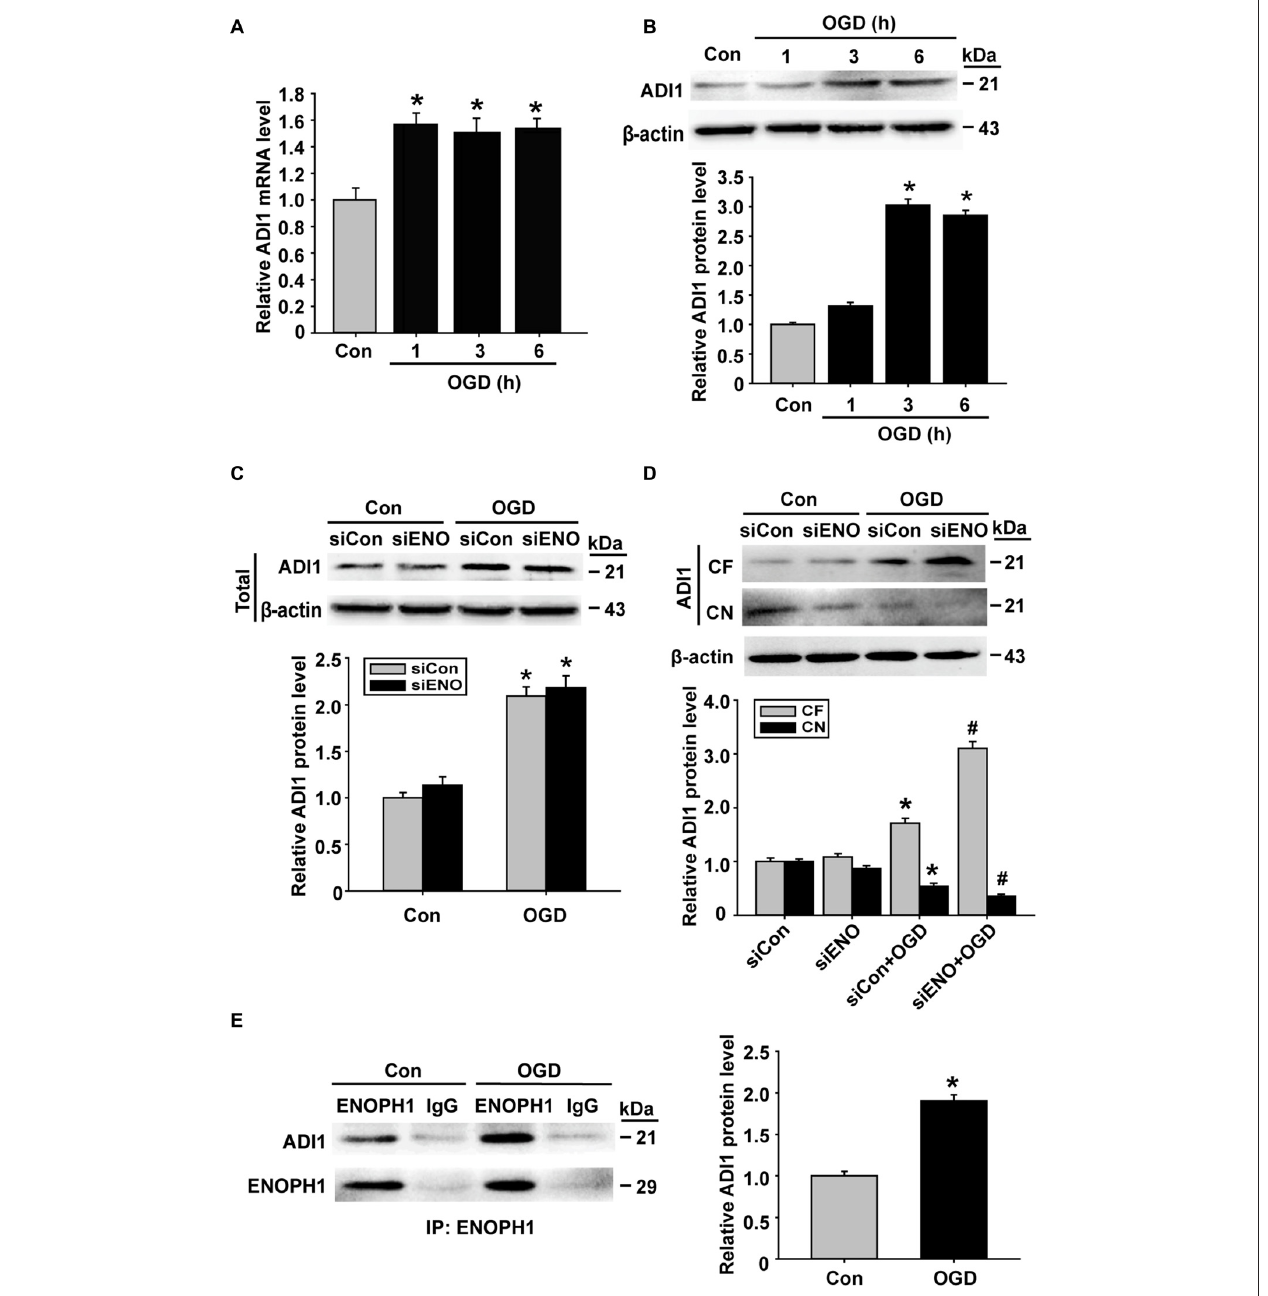
FIGURE 7 | ENOPH1 mediates OGD-induced ADI-1 relocation in endothelial cells. (A) Real time RT-PCR analysis showed that aci-reductone dioxygenase 1 (ADI1) mRNA expression was significantly increased in bEND3 cells at 1 h after OGD treatment and was further increased when OGD was prolonged to 6 h. ∗ P < 0.05 vs. Con; n = 4. (B) Western blot analysis showed that ADI1 protein levels were increased in 3 h OGD and 6 h OGD treated cells. Upper panel: representative immunoblots of ADI1 and the loading control β -actin; bottom panel: quantitative data of protein band intensity after normalization to β -actin., ∗ P < 0.05 vs. Con; n = 4. (C) Upper panel: representative immunoblots of ADI1 and the loading control β -actin; bottom panel: quantitative data showed that transfected with ENOPH1 siRNA had not prevented OGD induced upregulation of total protein level of ADI in bEND3 cells. ∗ P < 0.05 vs. siCon; n = 4. (D) Upper panel: representative immunoblots of ADI1 and the loading control β -actin; bottom panel: quantitative data showed that following OGD treatment, ADI1 levels in the CF was increased, while its level in CN was markedly reduced, which was enhanced by ENOPH1 siRNA. ∗ P < 0.05 vs. siCon, # P < 0.05 vs. siCon + OGD; CF, cytosolic fraction; CN, cytosolic nuclei; n = 4. (E) Left panel: representative immunoblots of coimmunoprecipitation of ENOPH1 and ADI1 from whole cell lysates of control cultures or OGD-treated cells with anti-ENOPH1 antibody or normal anti-IgG; right panel: quantitative data showed that OGD enhanced interaction of ENOPH1 with ADI1. ∗ P < 0.05 vs. Con; n =